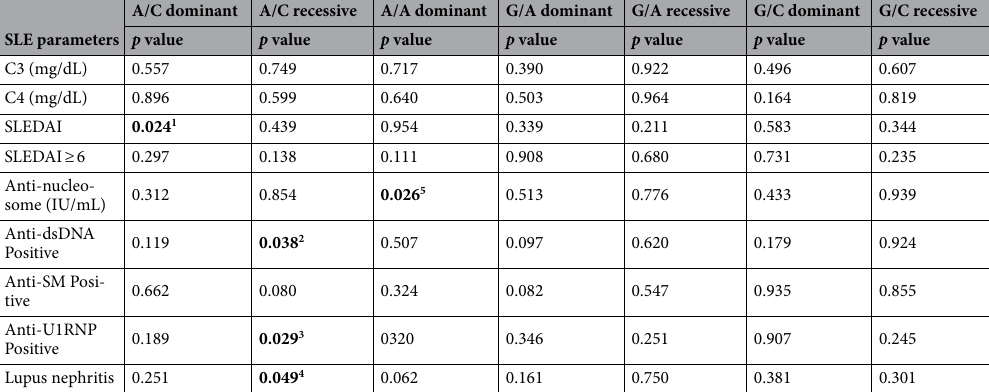
Table 5. Clinical and laboratory parameters of patients with systemic lupus erythematosus (SLE) according to FOXP3 -924 G > A (rs2232365) and -3279 C > A (rs3761548) haplotype models. Bold values represent statistically significant values. * p value adjusted by age, ethnicity, body mass index, and treatment. C3: complement 3; C4: complement 4; SLEDAI: systemic lupus erythematosus disease activity index; Anti-dsDNA: anti-double-stranded DNA; Anti-SM; anti-Smith; Anti-U1RNP: anti-U1 ribonucleoprotein. Haplotype models: A/C dominant (A/C carriers versus A/A, G/C, and G/A carriers), A/C recessive (ACAC versus A/A, G/C,